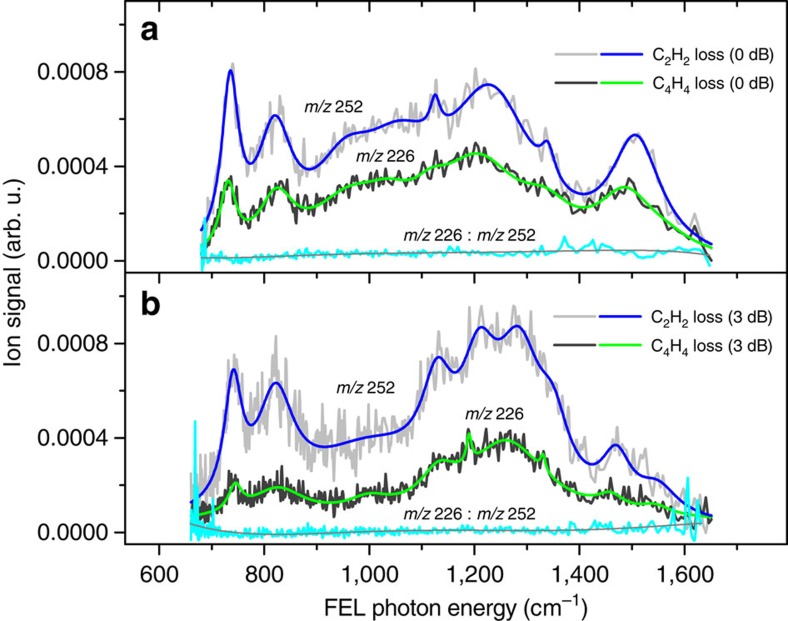
Individual ion signals of infrared multiple-photon dissociation channels of picene+.Recorded ion signals (grey) along FEL photon energy of C2H2 and C4H4 loss product ions before (a, 0 dB) and after (b, 3 dB) FEL power-level attenuation (corresponding to a macropulse energy reduction by a factor of 2). Each channel signal consists of two averaged FEL-scan data sets recorded at 0 dB (B0B1, sample from control measurements) and 3 dB (B2B3, sample from final spectra average) during a FEL beam-time session. The four signals are spectrally decomposed for which cumulative peak fit is depicted in blue (C2H2) and green (C4H4). The nearly constant ion signal ratio (cyan) between dissociation channels (m/z 226 : m/z 252)−1 is 1.73±0.55 (0 dB) and 2.52±0.83 (3 dB). The outliers at the limits of the spectral range produce relatively large standard deviations, and result from dividing weak ion signals at the baseline level featuring a strong random noise factor. At the peak of band f, the signal values for C2H2 (m/z 252) and C4H4 (m/z 226) losses and parent (m/z 278) (not shown) are 0.00034, 0.00081 and 0.070 at 0 dB, and 0.00021, 0.00069 and 0.099 at 3 dB (Supplementary Tables 18,19). Thus, the resultant dissociation yields are 0.0161 (0 dB) and 0.0090 (3 dB), which represent a 44% yield reduction on attenuation. Note that contrary to the band yields from partial spectra (Fig. 7) in which we usually integrate first the two product ion signals from the same scan measurement, here the band yields are obtained by integrating the same product ion from two scan measurements which then have somewhat different baselines and signal-to-noise levels. This brings an accuracy difference of 6% in comparison with the former procedure from which dissociation yields feature a 50% reduction on attenuation (see Table 2).